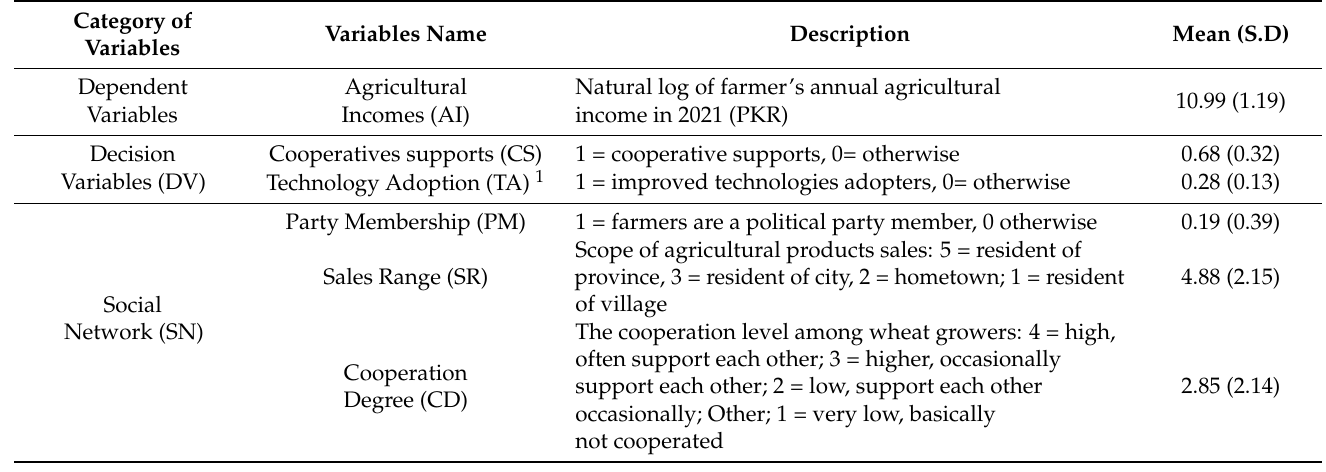
Table 3. Variable description and summary